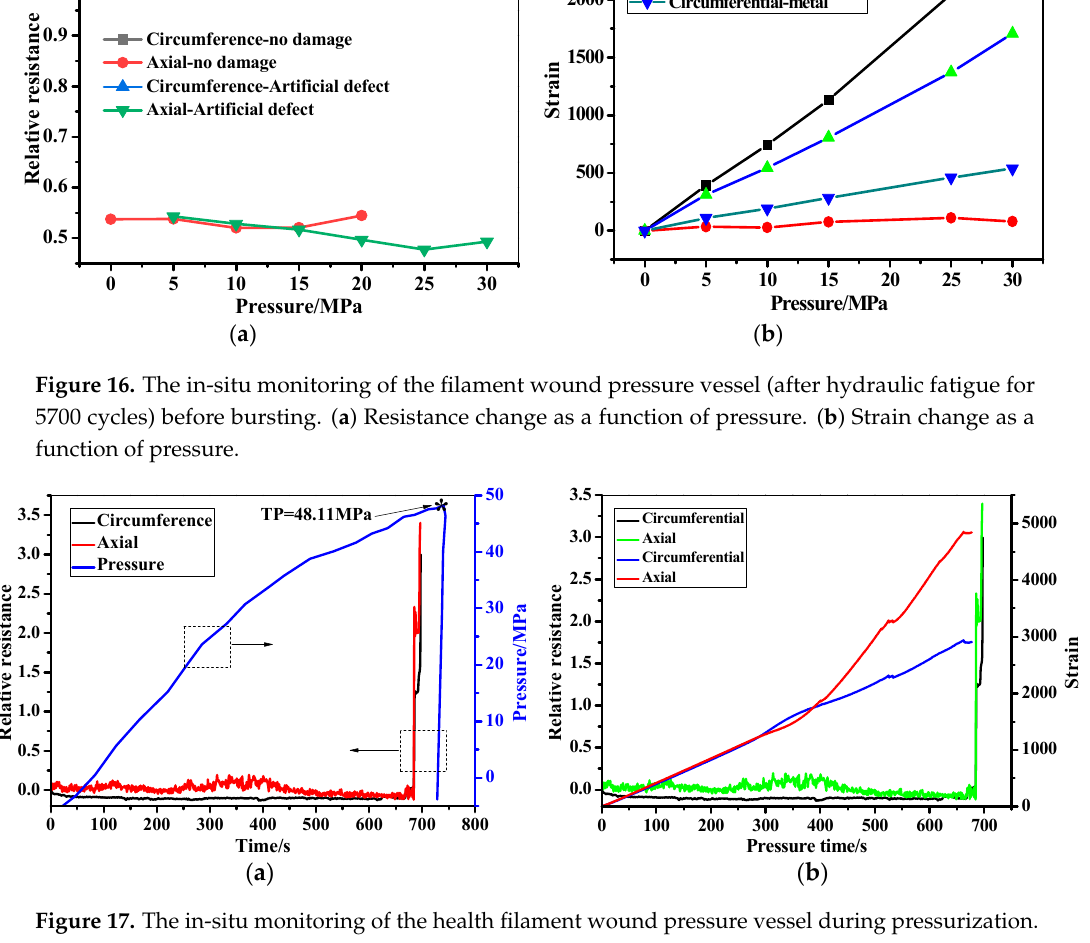
pressurization. ( a ) Resistance, pressure–pressure time. ( b ) Resistance, strain–pressure time.